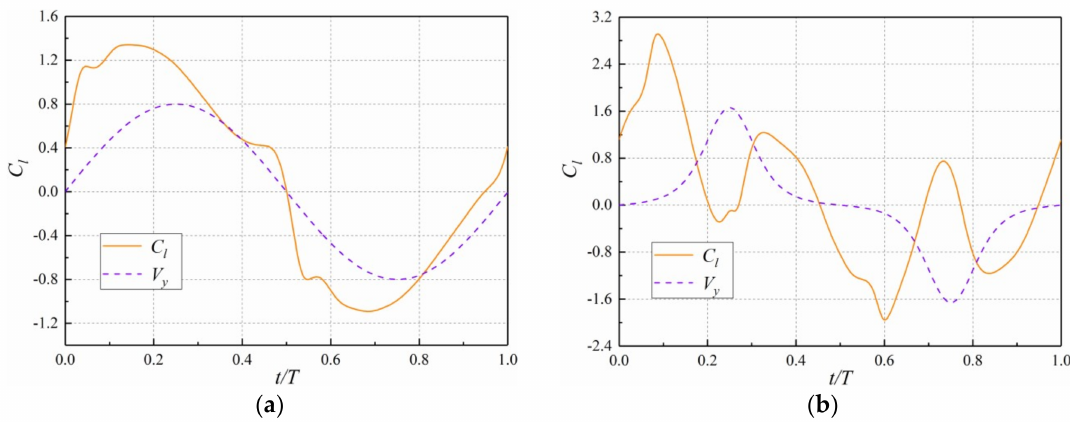
Figure 8. The C l curves of the upper foil under different K h at k = 0.8: ( a ) K h = 0; ( b ) K h =